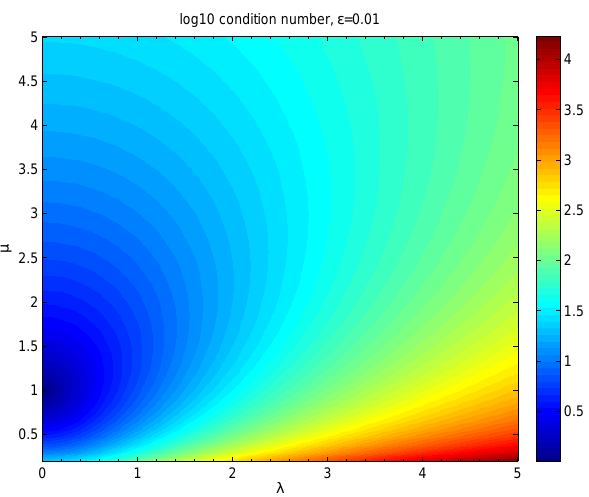
Fig. 2. Logarithm of the condition number c of the position tensor R in terms of λ = ‘/L and µ = M/L for ε = 0 .